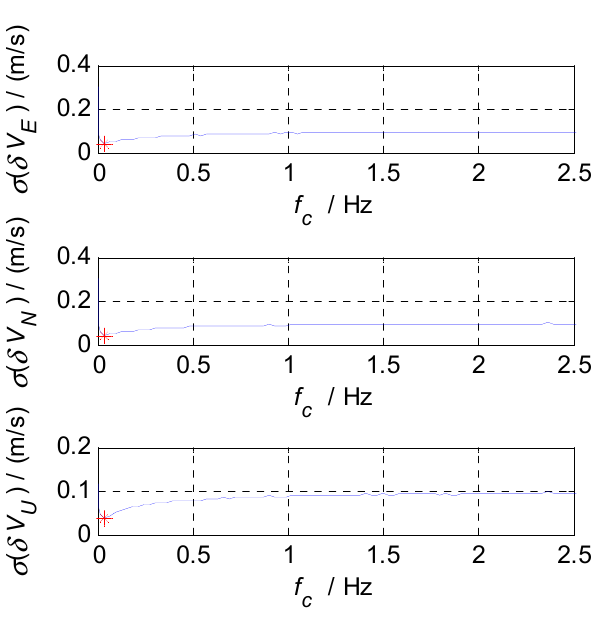
Figure 8. The relationship between f c